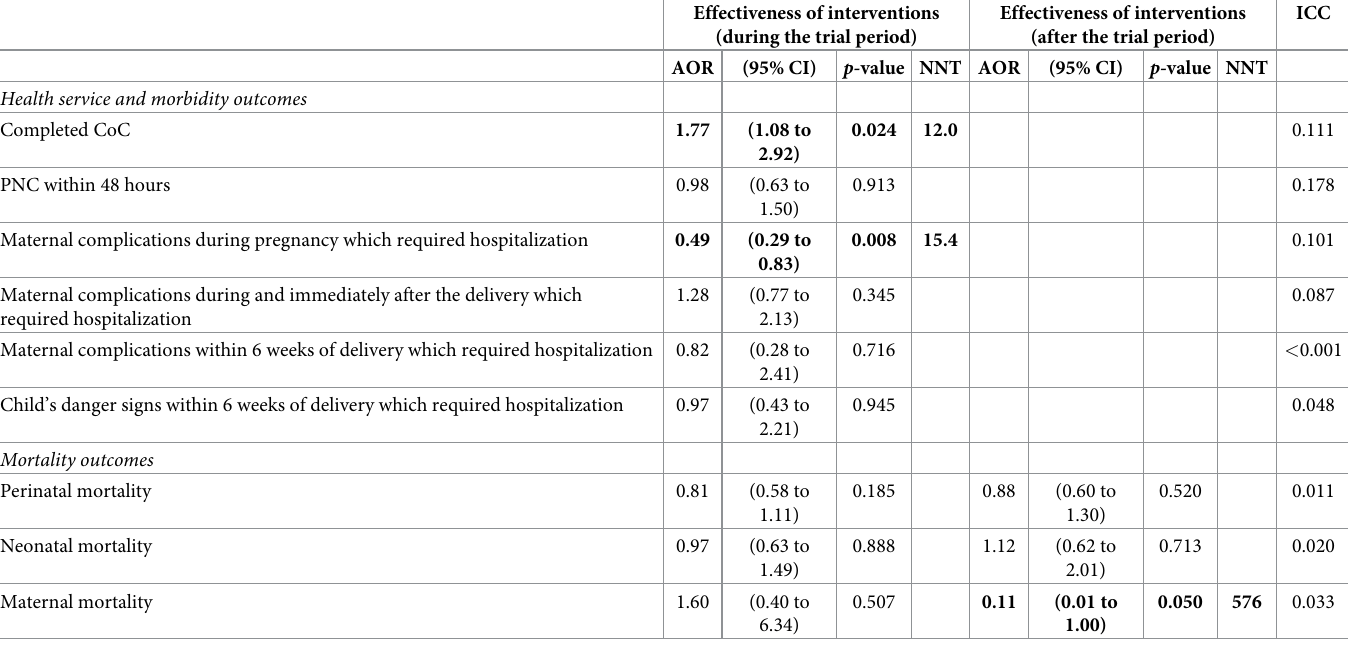
Table 5. Effectiveness of